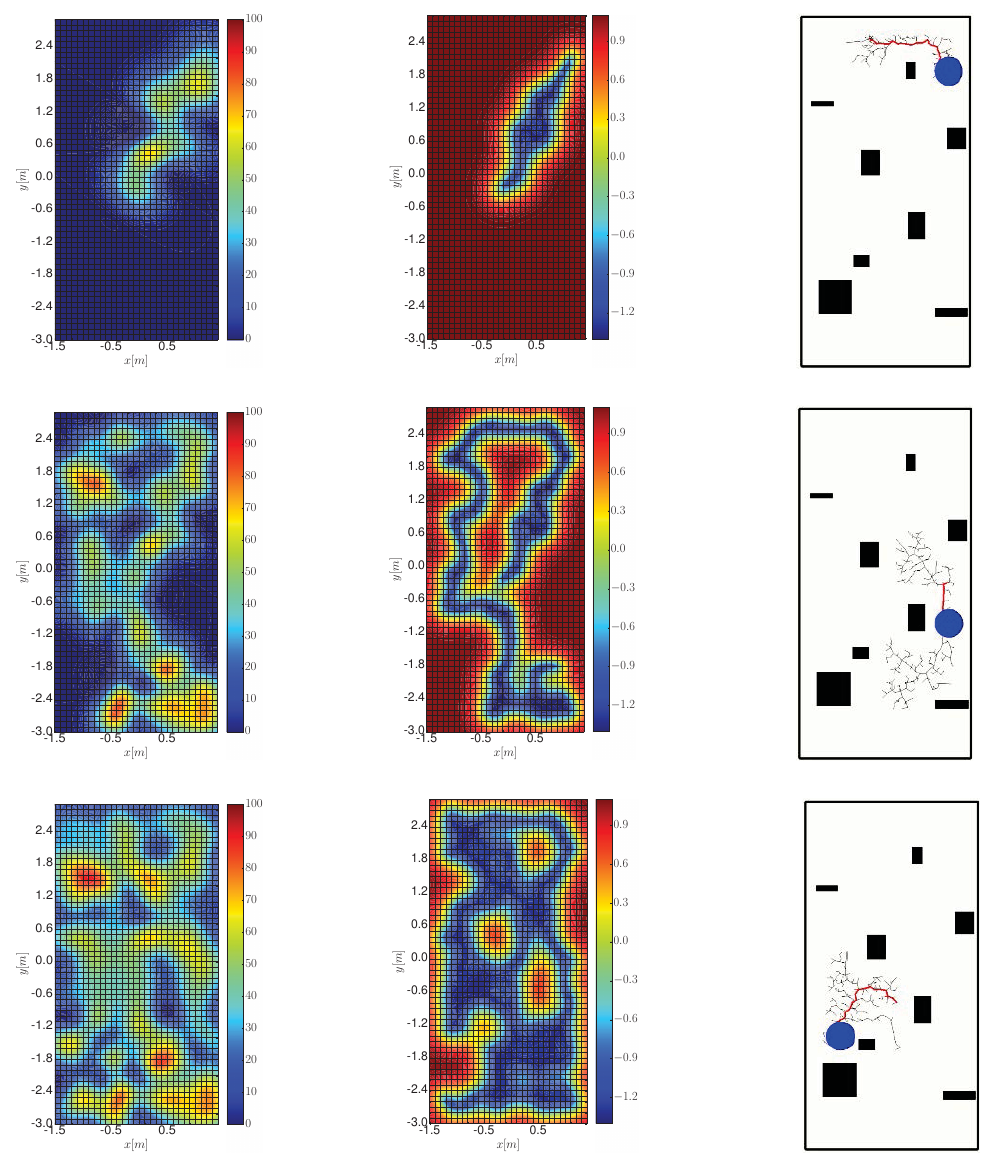
Figure 10. Screenshots of Algorithm 1 execution. The three rows correspond to three instants of times: 133, 502 and 946 s. From left to right, the columns are the estimation of the process (measured in µ T), the entropy, and the planned path using Algorithm 3.